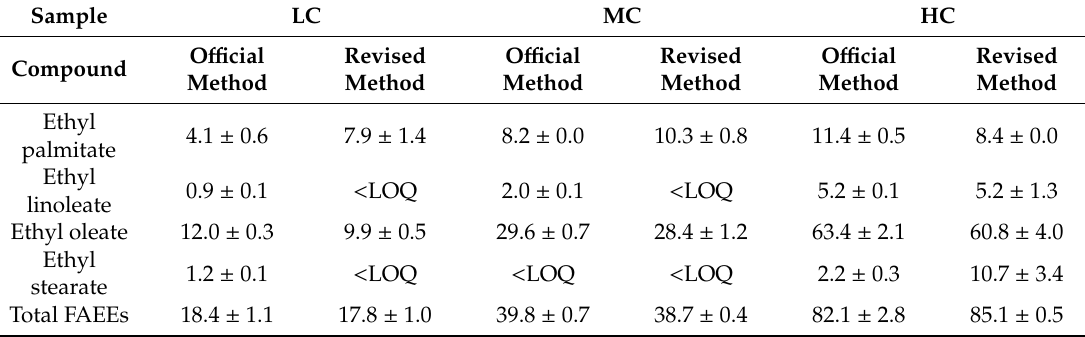
Table 5. Mean value (three replicates as regards to the results obtained by the o ffi cial method; three replicates for sample LC and two replicates for sample MC and HC as regards to the results obtained by applying the revised method) and standard deviation of the content of ethyl oleate and fatty acid ethyl esters measured by both the o ffi cial method (EU Reg. 61 / 2011) and revised one (o ff -line HPLC-GC-FID) on three olive oil samples. Data are expressed as mg / kg of oil. Sample LC–low content: Extra virgin olive oil with a content of FAEEs under the legal limit; sample MC–medium content: Non-extra virgin olive oil with a medium content of FAEEs beyond the legal limit; sample HC–high content: Non-extra virgin olive oil with a content of FAEEs much higher than the legal